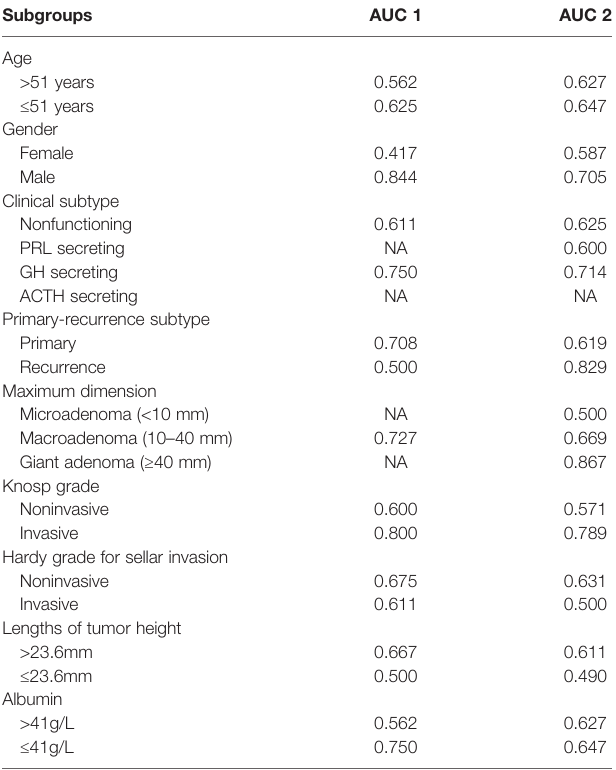
TABLE 3 | ROC analysis in subgroups from validation cohort 1 and